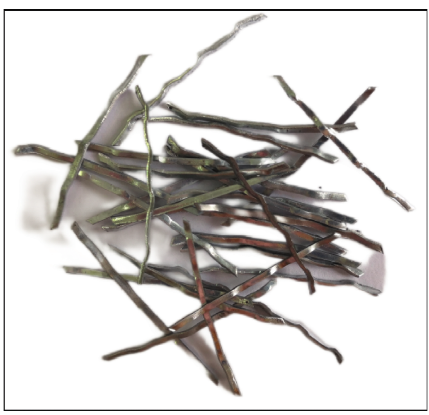
Figure 1: The shape of the corrugated steel fibers. Table 1: Composition of the alkali activator solution for the AAS